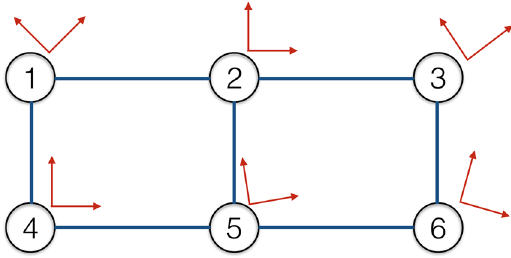
Figure 1. An illustration of a six-node quantum hybrid network: There is a qubit at each node, respectively; Projective measurements are performed at the individual qubits; Nodes are interconnected by classical communication links so that the outcomes of the measurements can be